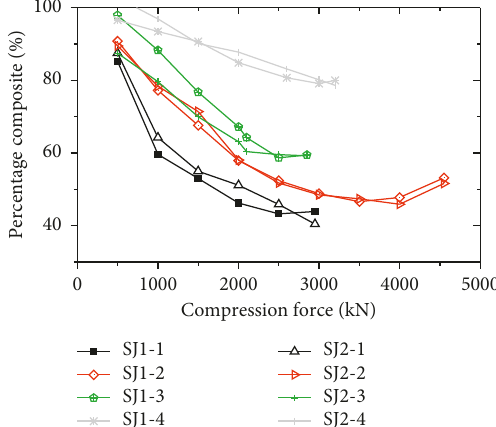
Table 5: The revised elastic modulus coefficient c